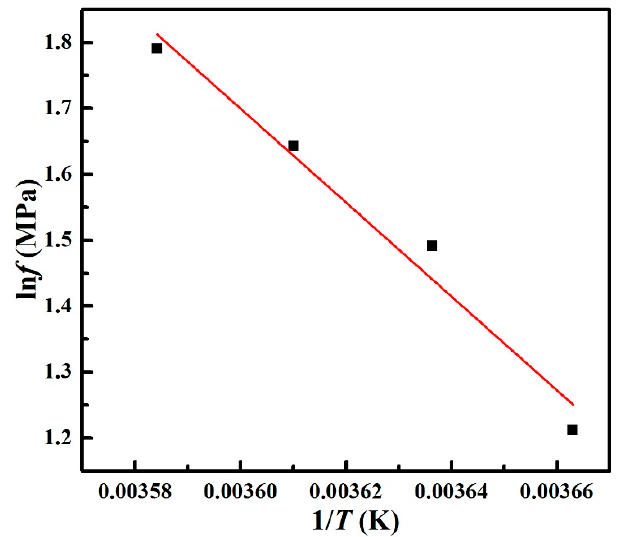
Figure 8. Linear fit of lnƒ with 1/ T .